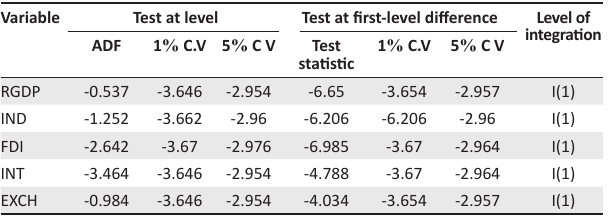
TABLE 2: Results of unit root test.